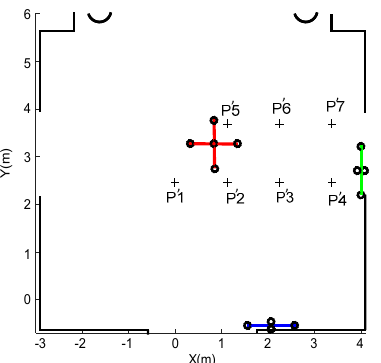
Table 1. Coordinates of the central beacon B 1 for every ULPS in the considered workspace.